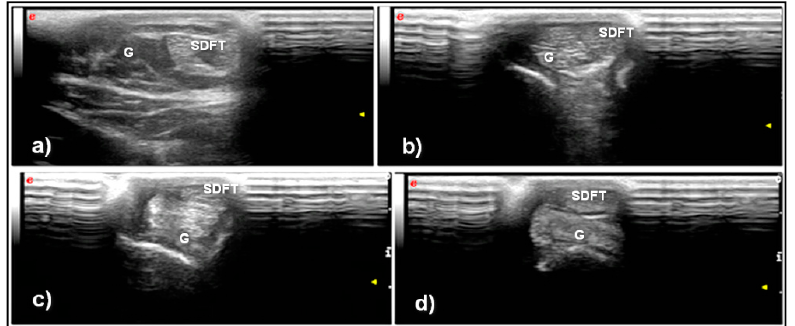
Figure 2. Transverse ultrasonographic scan of the normal ovine CCT: ( a ) myotendinous junction, ( b , c ) middle part and ( d ) insertion on the calcaneal tuberosity. Note that toward the distal part, the superficial digital flexor tendon (SDFT) moves to a more superficial position than the gastrocnemius tendon (G).